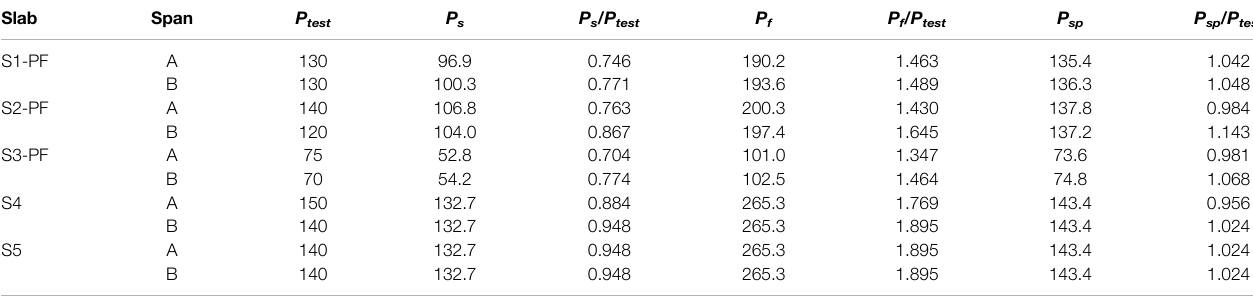
TABLE 3 | Comparisons between the experimental results and predicted results of the specimens. Slab